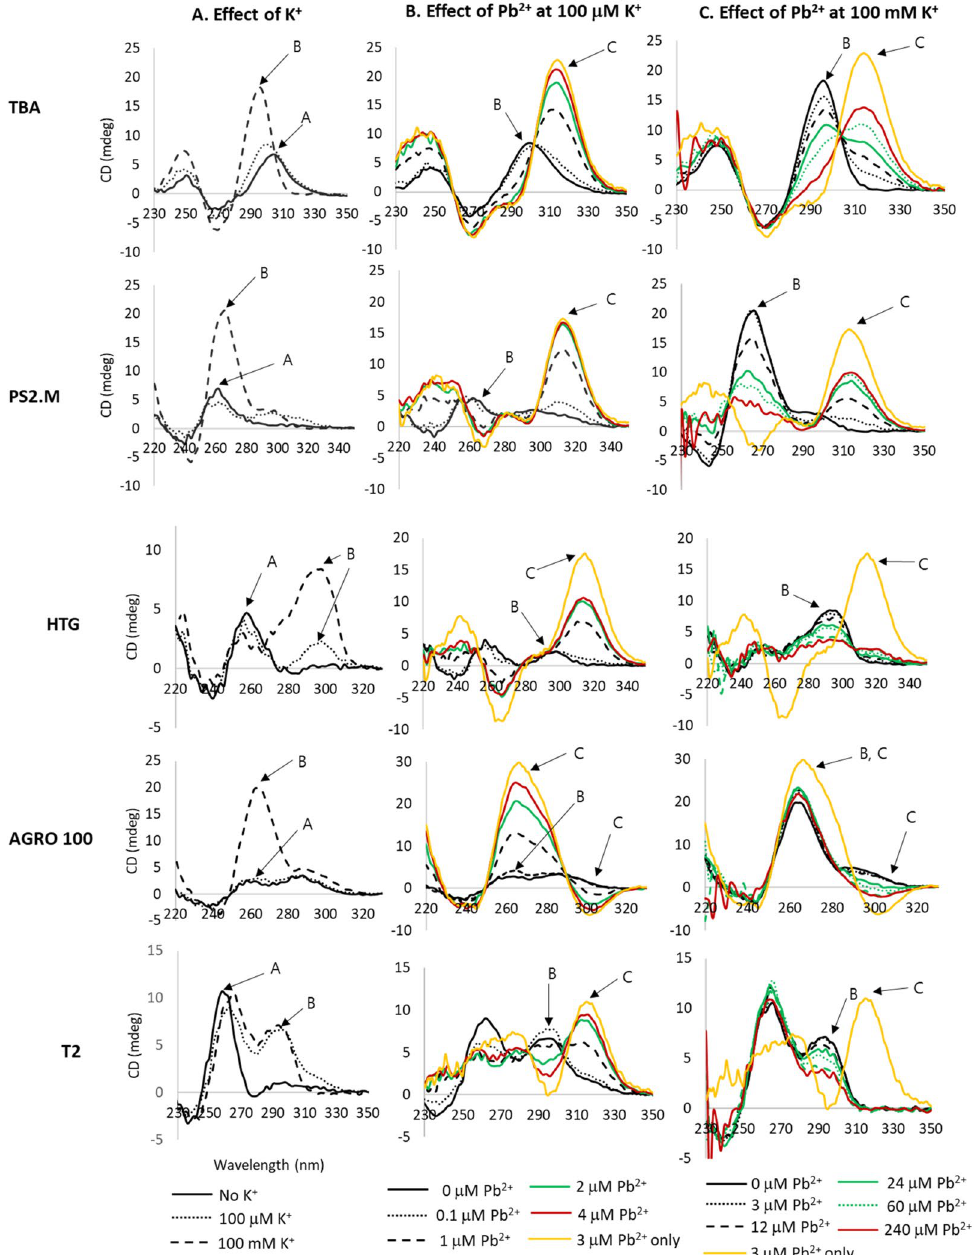
Figure 2. Circular dichroism (CD) spectra G-QDs by addition of K + and Pb 2+ . ( A ) Structural changes observed in five types of G-QDs by addition of K + . ( B , C ) Structural changes observed by incorporation of Pb 2+ . ( B ) Effect of Pb 2+ at 100 μM K + ; ( c ) effect of Pb 2+ at 100 mM K + . Yellow line is the spectra induced by Pb 2+ without K +